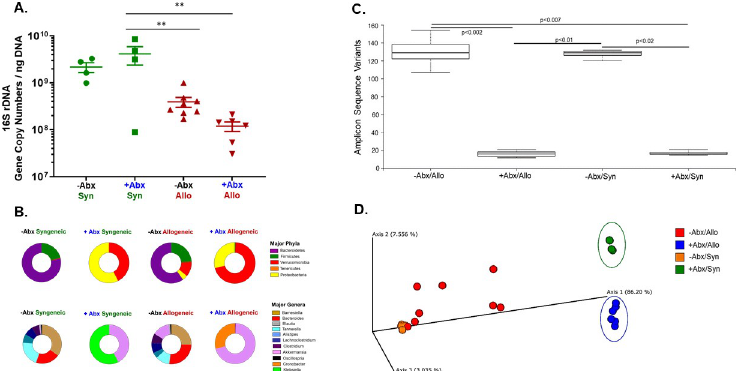
Fig 6. Alterations in fecal bacterial density and composition in untreated or Abx-treated mice. A). Fecal bacterial density was quantified at 4 weeks post T cell transfer. Data are expressed as 16s rRNA gene copy numbers per ng of DNA. Asterisks ( � ) designate significant differences among the 3 groups ( �� p < 0.01). B). Relative abundance of the major phyla and genera were determined using 16S rDNA amplicon sequencing of fecal DNA. C). Amplicon Sequence Variants (ASVs) with Kruskal-Wallis pairwise comparisons was used to quantify α diversity within each group. ASVs analysis revealed that the microbial diversity within the +Abx/Syn and +Abx/Allo groups were significantly reduced when compared with the– Abx/Syn and– Abx/Allo groups. D) . Principal Coordinate Analysis (PCoA) of weighted UniFrac distance was used to quantify differences between microbial communities ( β Diversity). Using pairwise analysis of similarities, this plot reveals that the +Abx/Syn and +Abx/Allo groups were significantly different from each other as well as significantly different from the other two groups (p < 0.05).